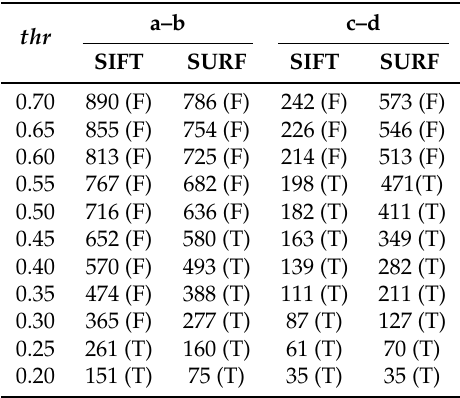
Table 3. Matching